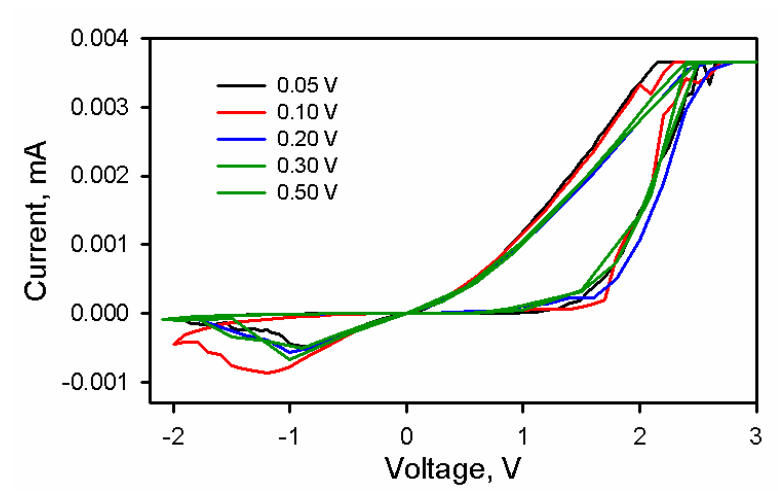
Figure 4. The I-V characteristics at multiple sweeping rates.